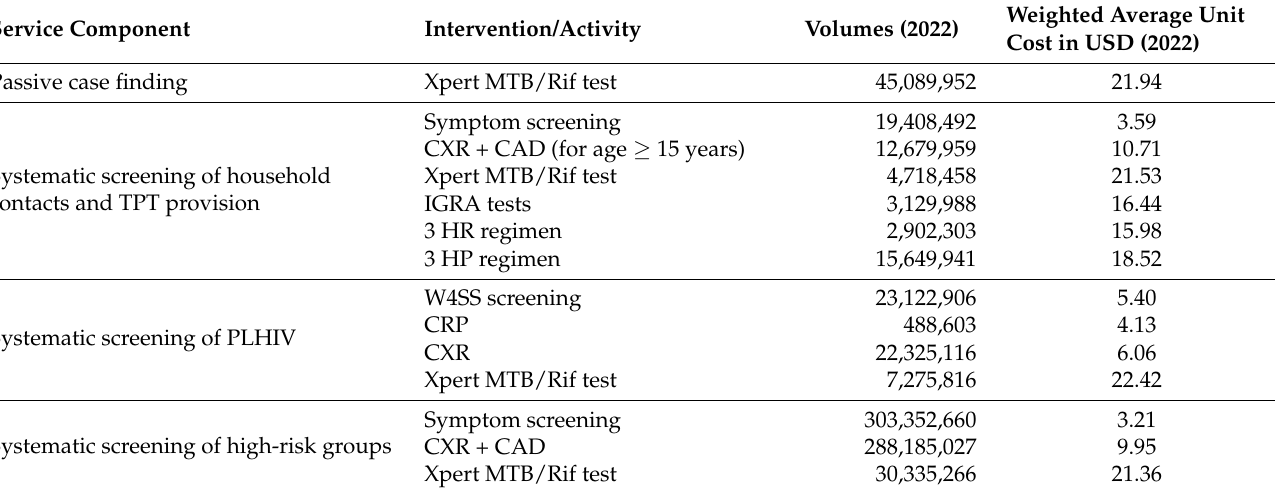
Table 5. Volumes of certain key interventions and weighted average unit costs across 33 high-burden countries required to achieve UNHLM TB case finding and TPT